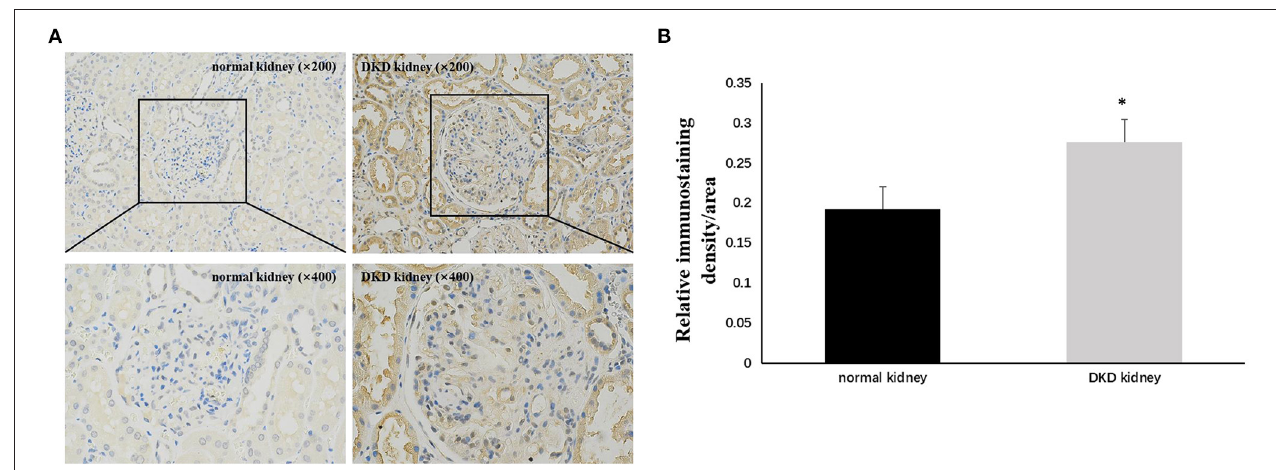
FIGURE 2 | Increased expression of GSDMD in renal tissues of DKD patients. (A) IHC studies revealed increased expression of GSDMD in DKD patients ( × 200 and × 400) (B) Averaged relative intensity for the staining of GSDMD in kidney biopsies of normal vs. DKD patients (* P < 0.05).